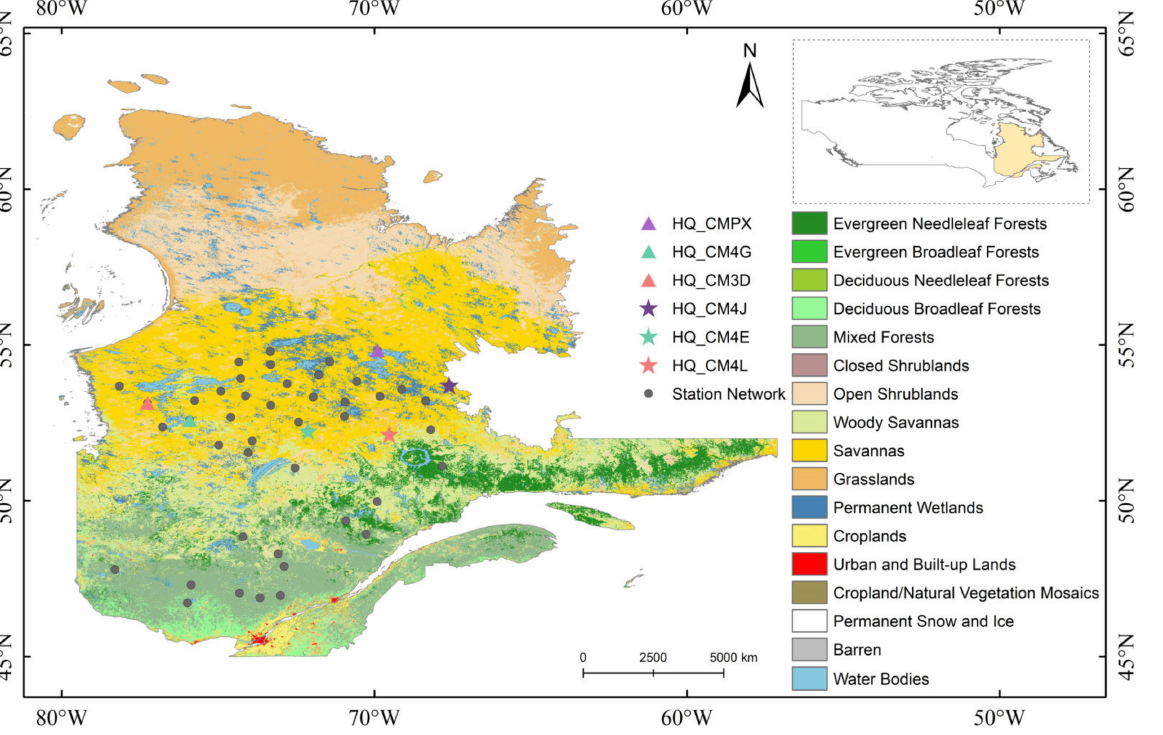
Figure 1. Spatial distribution of stations in Quebec, Canada. International Geosphere-Biosphere Programme (IGBP) land surface types are represented in colors according to the MODIS-MCD12Q1 product. Stations marked with stars and triangles are stations with good and bad retrieval perfor- mances, respectively, described in detail in Section